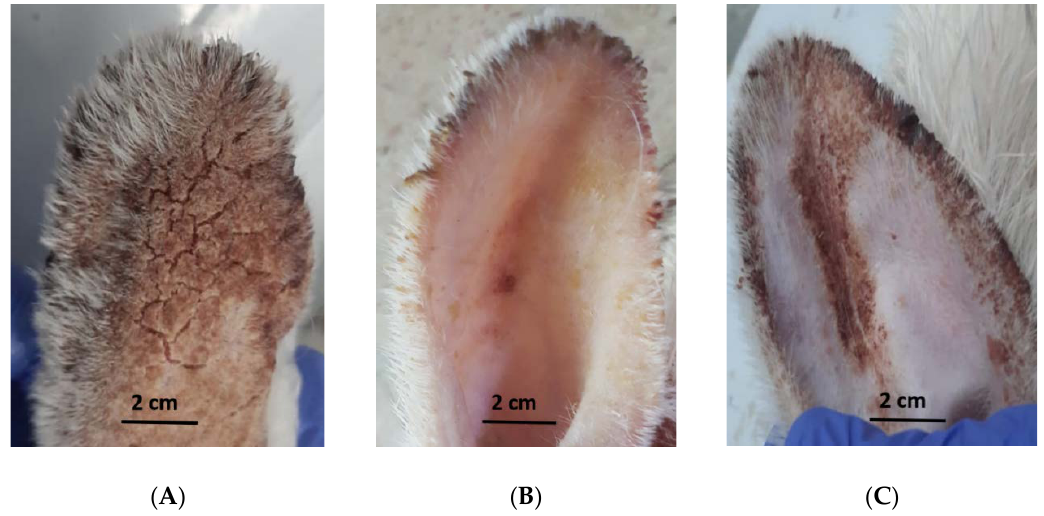
Figure 5. Macroscopical examination of infected rabbits with mange at the end of the experiment. ( A ) control group; ( B ) coconut seed extract group; and ( C ) ivermectin group.